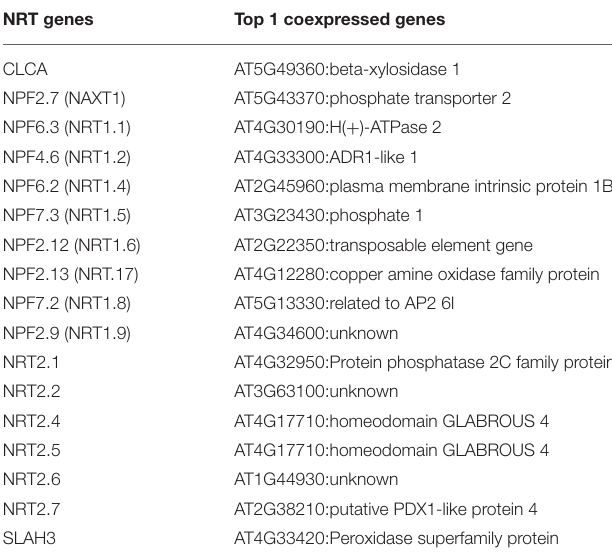
TABLE 1 | The top1 correlated genes for each of 17 N